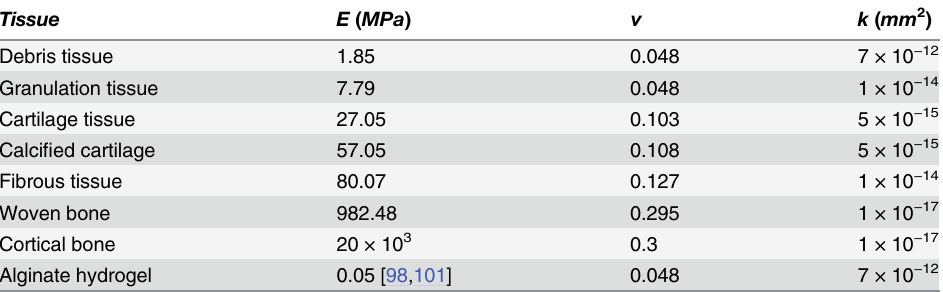
Table 1. Poroelastic mechanical properties considered for the different tissues [31,94 – 96] and for the alginate